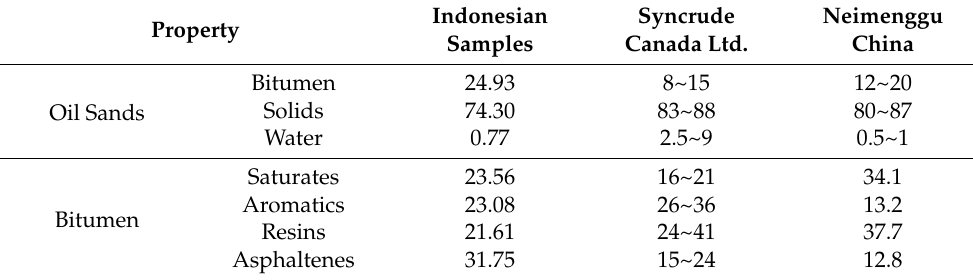
Table 1. Basic properties of Indonesian oil sands and bitumen.